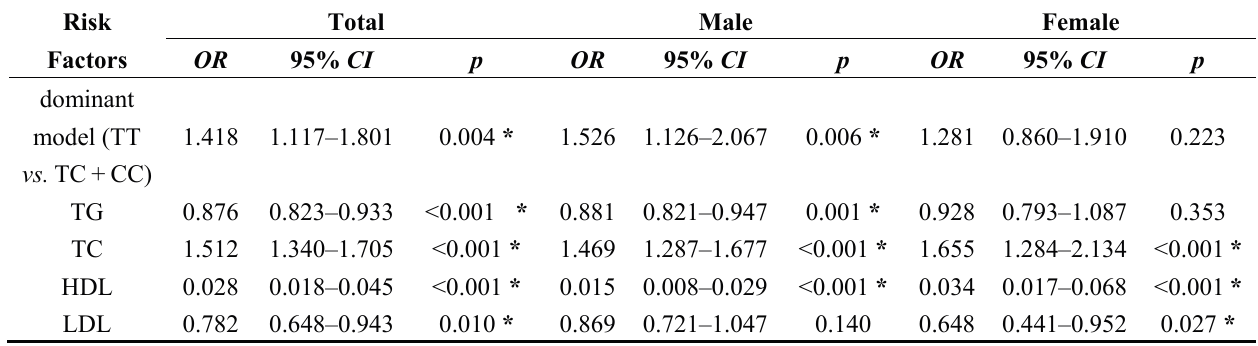
Table 5. Multiple logistic regression analysis for T2DM patients and control subjects